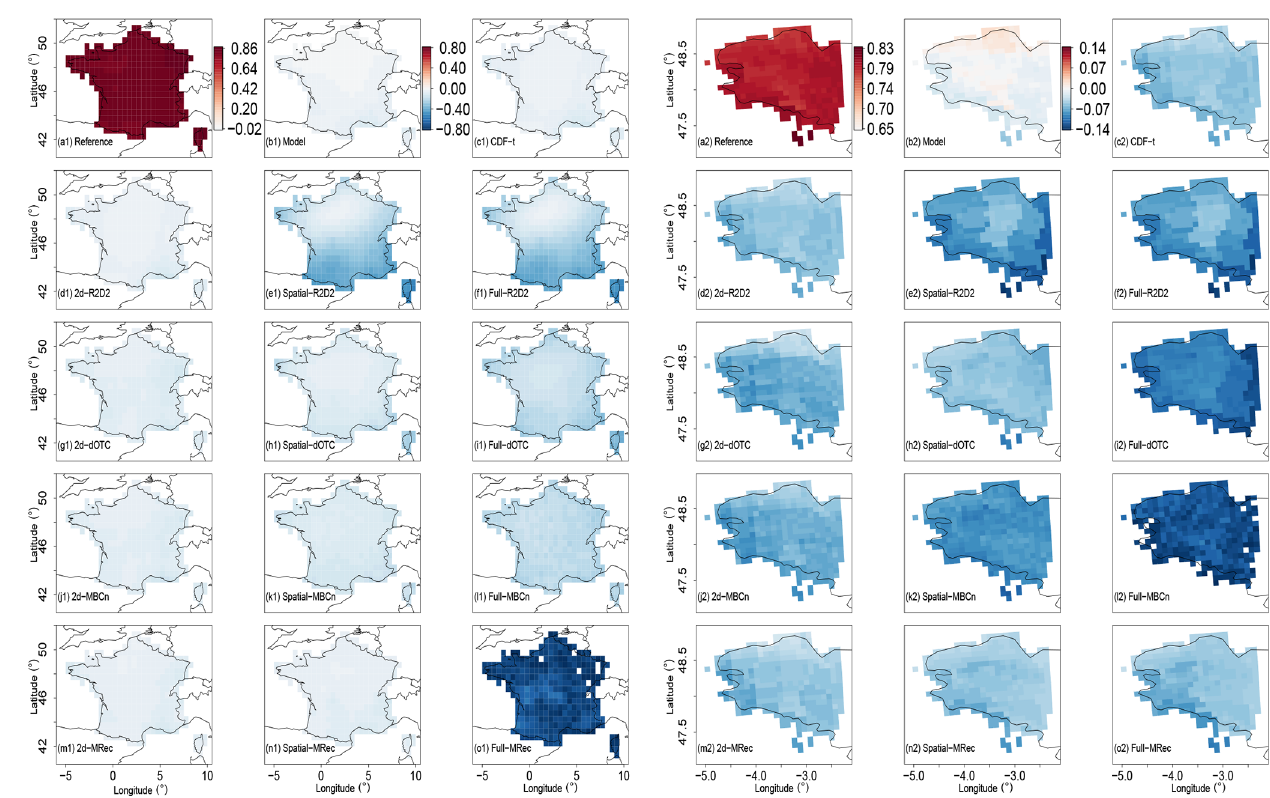
Figure 4. Differences of order 1 Pearson autocorrelation for temperature using (a1–o1) WFDEI reference and (a2–o2) SAFRAN reference during winter over the 1979–2016 period. Results are shown for reference, plain IPSL, CDF-t, R 2 D 2 , dOTC, MBC-n and MRec outputs for 2d-, Spatial- and Full- versions. Note that the color scales between panels (a1) – (o1) and (a2) – (o2) are not the same to better emphasize intensities of values of the two regions.